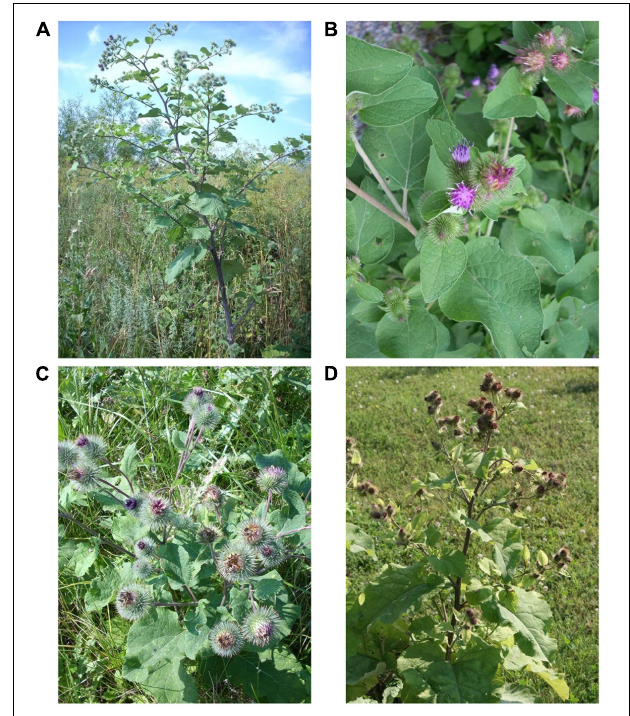
FIGURE 1 | Plants of Arctium . (A) Arctium lappa ; (B) Arctium minus ; (C) Arctium tomentosum ; (D) Arctium nemorosum